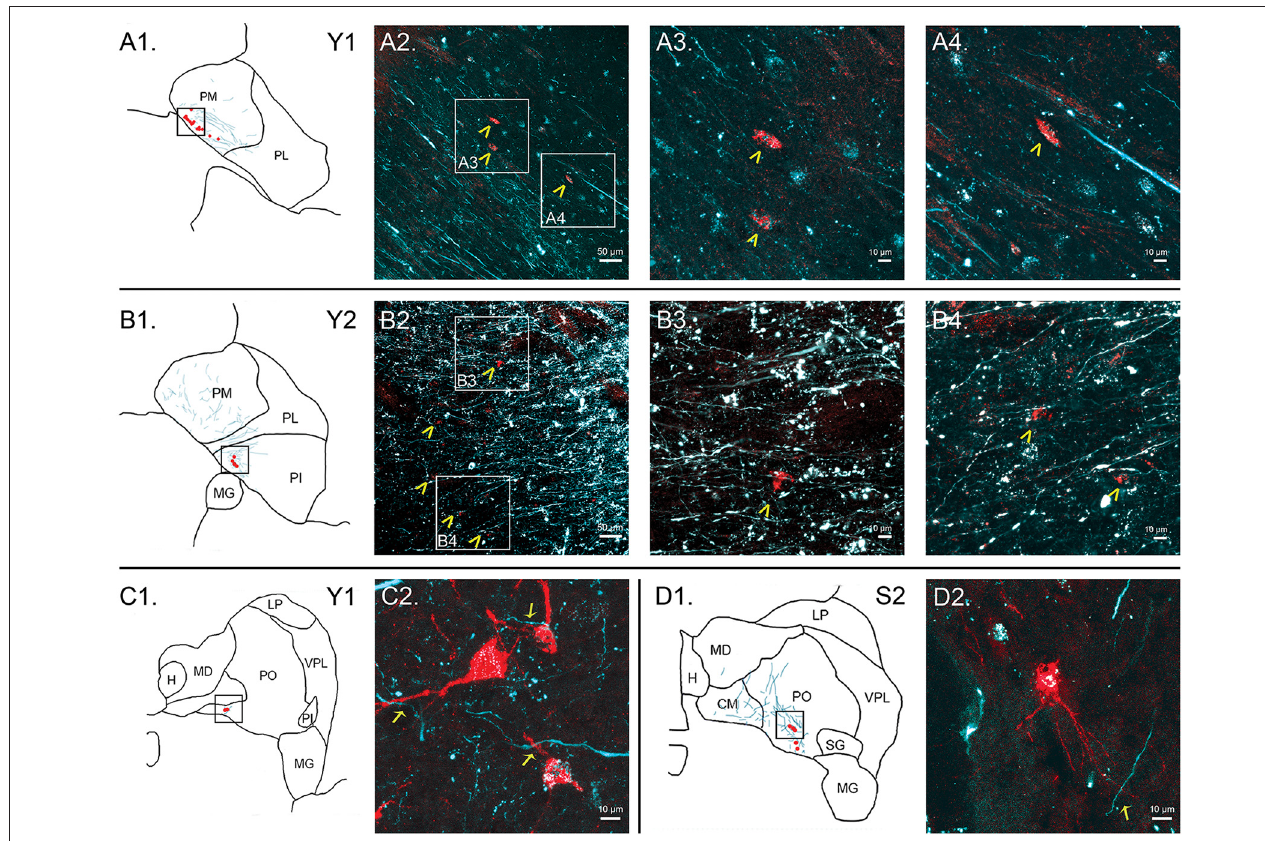
FIGURE 7 | Colocalization of retrograde and anterograde labeling in the pulvinar. FE-labeled fibers resulting from injection into the SC are shown in cyan. CTB-immunoreactive cell bodies resulting from injection into the amygdala are shown in red. Atlas pictures are included to illustrate where each photo was taken. The case from which the images are derived is shown in the upper right corner. (A) Images of cells within PM, case Y1. Atlas image is shown in (A1) . Low power confocal image (20 × magnification, (A2) ) showing a band of labeled cell bodies (red) within the field of labeled axons running along the medial boundary of the PM, parallel to the brachium of the SC. Atlas image is shown in (B1) . Chevrons indicate cell bodies. Panels (A3,A4) are higher power (60 × ) magnifications of the areas indicated by boxes in (A2) . (B) Images of cells within PI, case Y2. Atlas image is shown in (B1) . Low power (20 × , (B2) ) confocal image showing colocalization of labeled cell bodies and axons in PI. Chevrons indicate cell bodies. Panels (B3, B4) show high power (60 × ) magnification. As in (A) , chevrons in B3 and B4 indicate areas of overlap in labeled cell bodies and axons. (C) Cells within PO, case Y1. Atlas image shown in (C1) . High power (63 × ) confocal image showing individual cell bodies and finer axonal processes in close proximity in (C2) . (D) Cells within PO, case S2. Atlas image shown in (D1) . High power (63 × ) confocal image in (D2) . Arrows indicate close associations between labeled terminal boutons and labeled cells. Scale bars are as indicated in each panel.